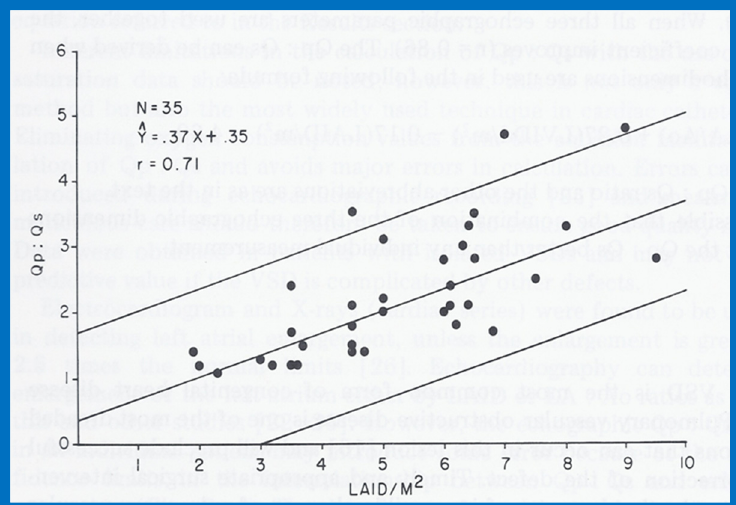
Figure 1. Scattergram demonstrating the relationship of left atrial internal dimension/m 2 (LAID/m 2 ) with pulmonary-to-systemic flow ratio (Qp:Qs) in patients with isolated ventricular septal defects. The central line is regression line and the parallel lines demarcate the confidence intervals. The number of patients (N), regression equation and correlation coe ffi cient (r) are shown in the insert at the top left. Reproduced from Rees AH, Rao P.S., et al.